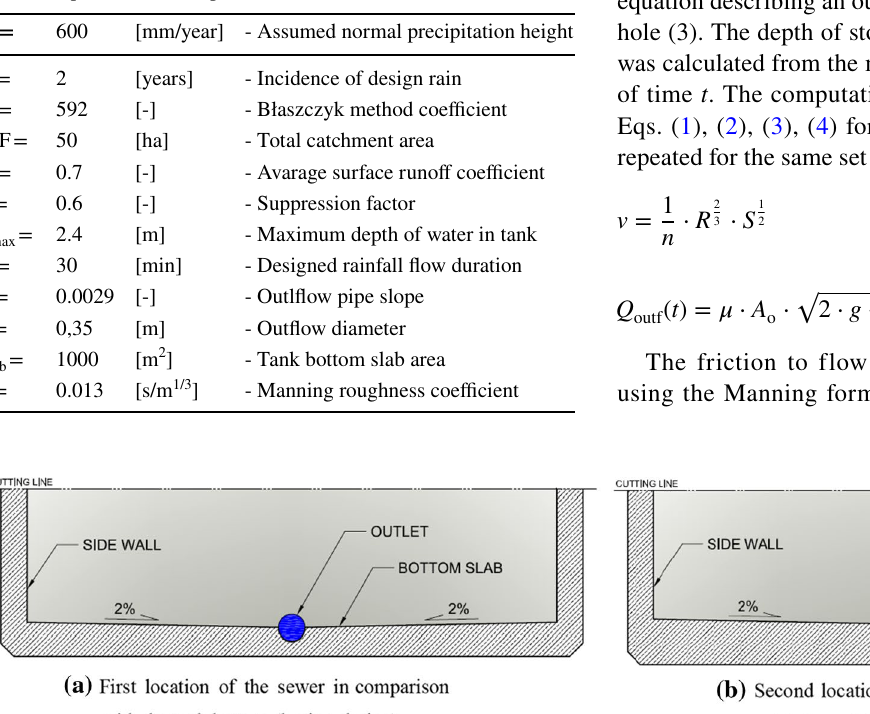
Table 1 Input data for computations